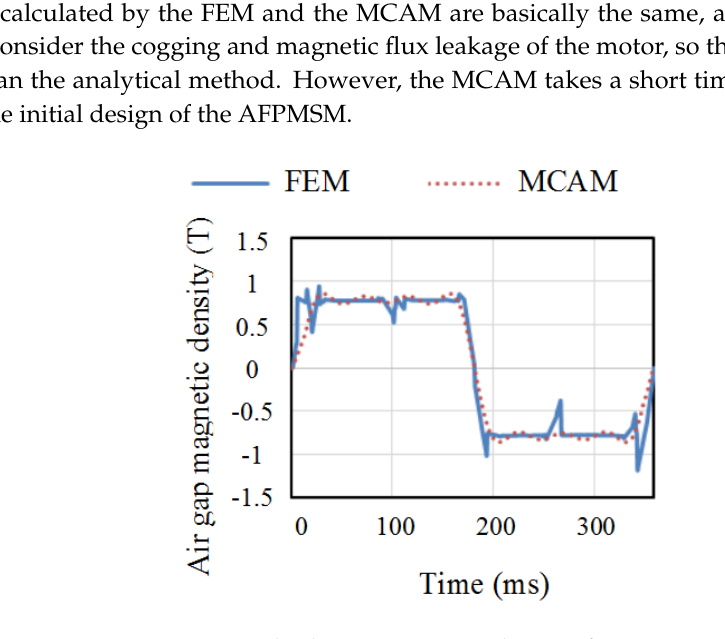
Figure 4. No-load air gap magnetic density of AFPMSM.